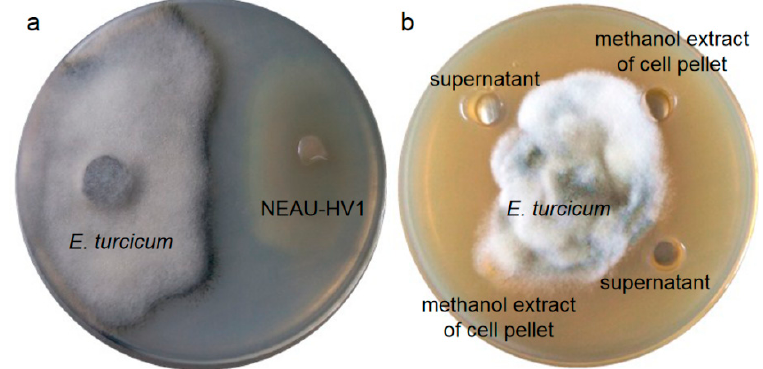
Figure 4. The antagonistic activity of NEAU-HV1 T against E. turcicum ( a ) and the antifungal activity of the supernatant and cell pellet of NEAU-HV1 T against E . turcicum ( b ).